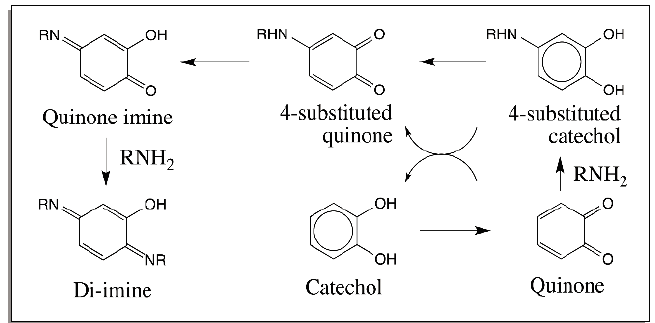
Figure 5. Reactions of quinone with external amines. Quinones formed by the oxidation of catechols react with external amino group forming 4-substituted catechols. These catechols are unstable and form further adducts via substituted quinones.